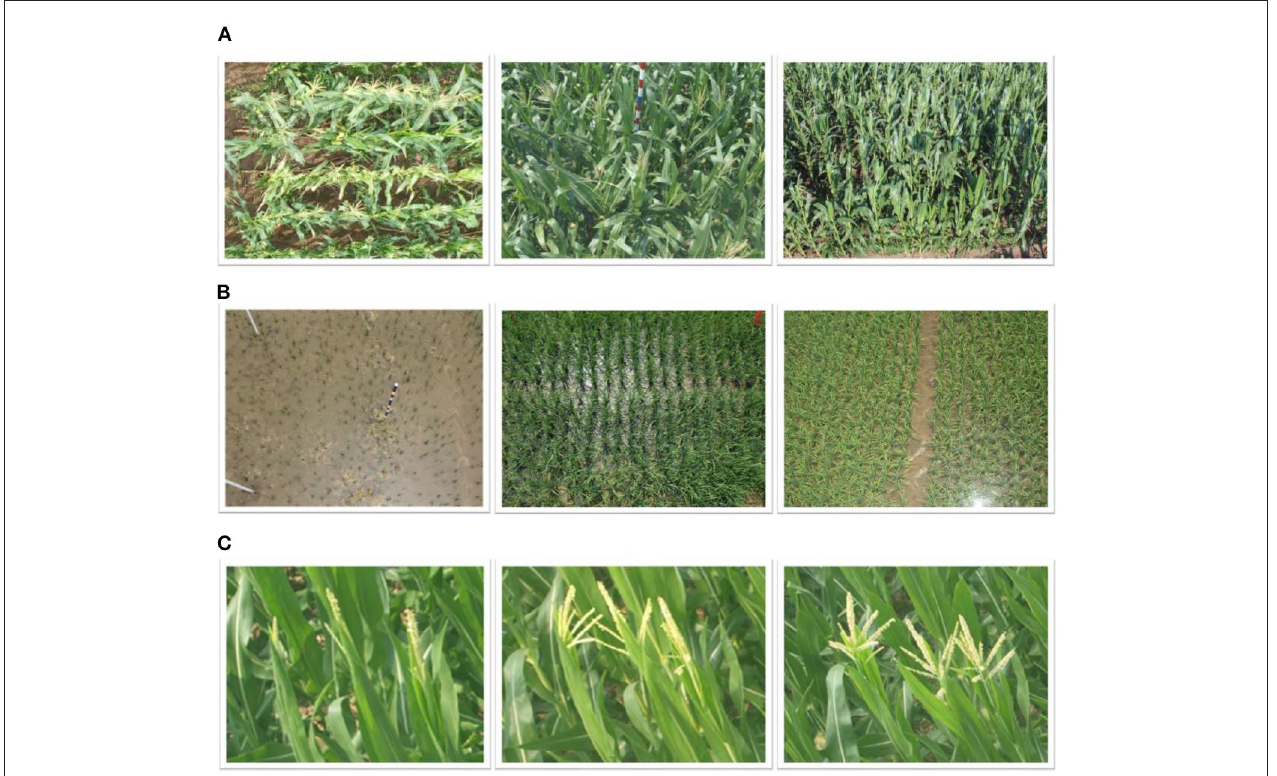
FIGURE 1 | Typical causes of domain gaps in plant counting. (A) Different camera views. (B) Scale variations in different locations. (C) Different appearances due to different growth